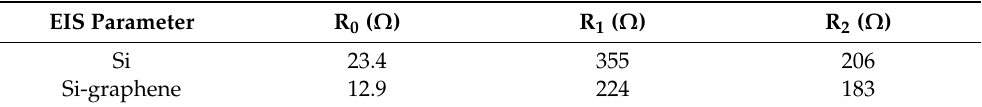
Figure 6. ( a ) Full-scale and ( b ) magnified EIS spectra of Li/Si and Li/Si-graphene coin cells. Table 1. EIS parameters of the Li/Si and Li/Si-graphene coin